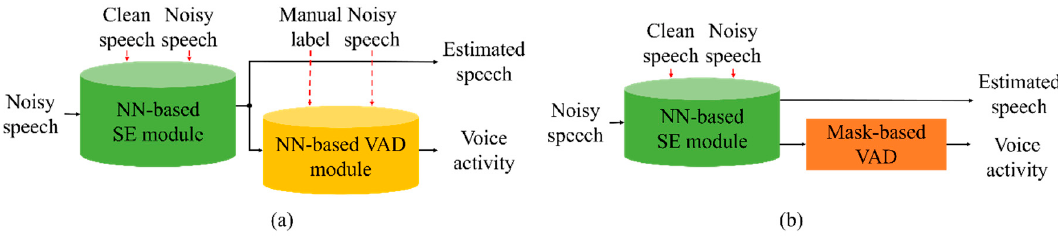
Figure 4. Comparison of block diagrams concerning the combination of speech enhancement and voice activity detection: ( a ) a conventionally combined approach and ( b ) the proposed approach.